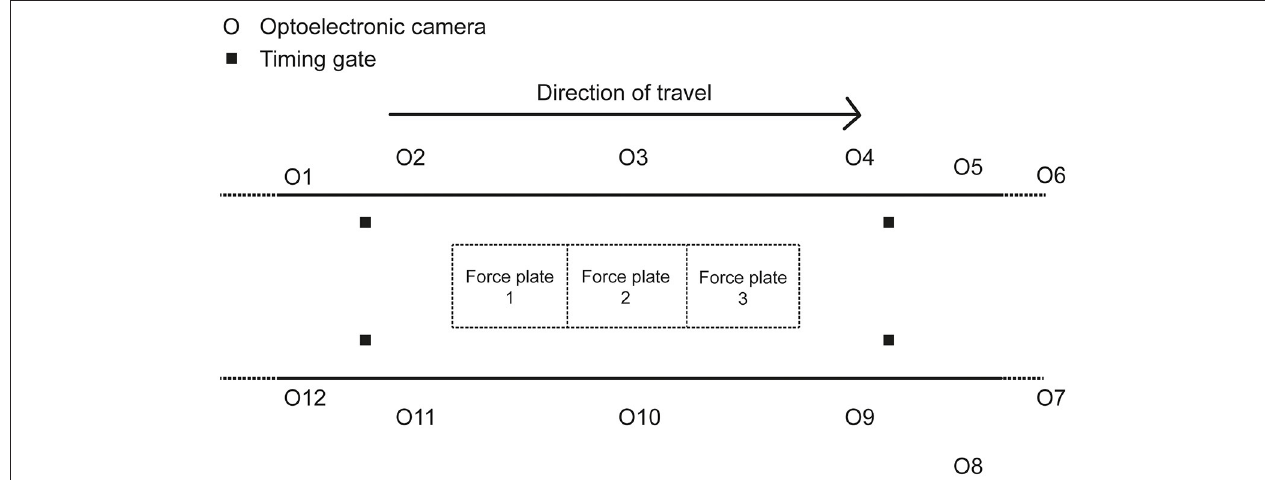
Frontiers in Sports and Active Living |